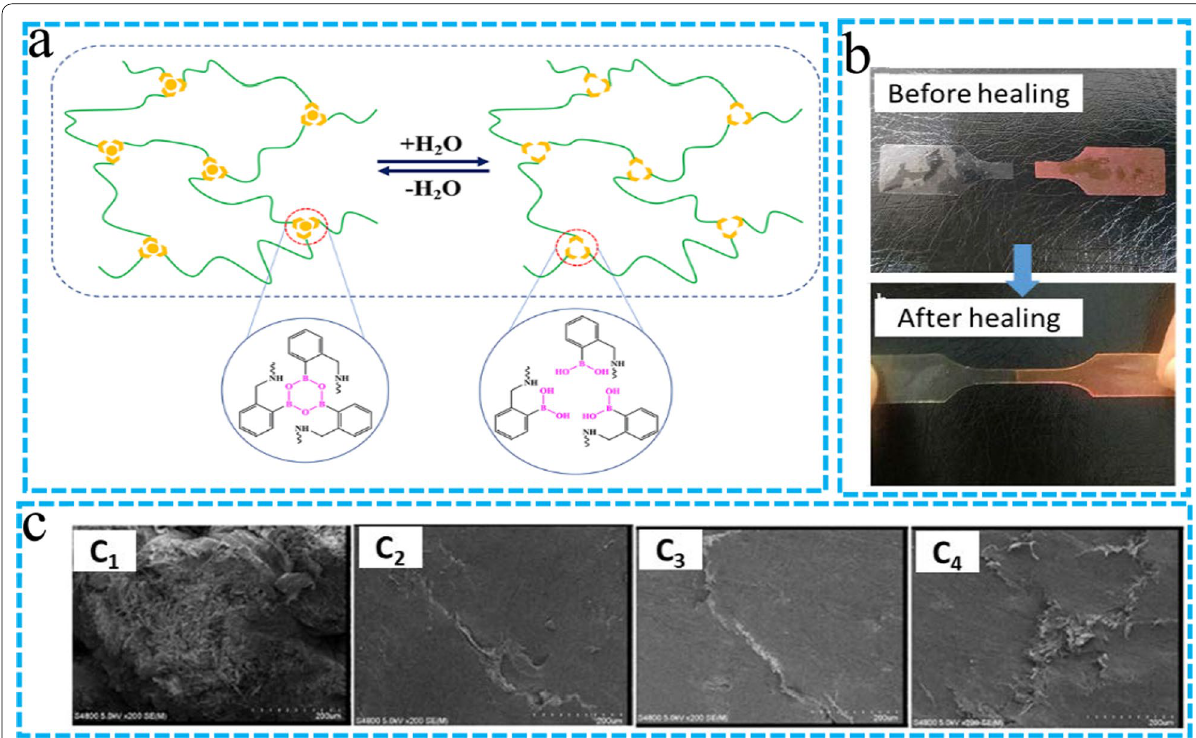
Fig. 13 a The healing mechanism of composite film containing boroxine bonds. b Photos of dyed and undyed film samples being cut into two separate parts and healed. c SEM photos of worn surface of original leather (C 1 ), WPU finished leather (C 2 ), AMPBA-PPG/WPU composite film (C 3 ) and AMPBA-PPG/WPU composite finished leather after healing (C 4 ). Reprinted with permission form Reference [84]. Copyright 2021,Springer